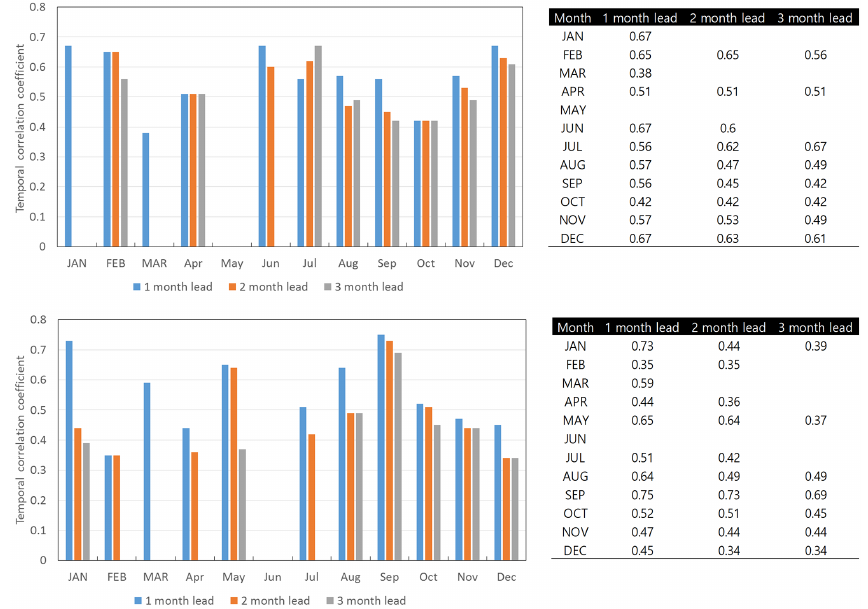
Figure 5. Temporal correlation coefficients (TCC) according to changes in lead time for predicting precipitation (top) and temperature (bottom) using multi-model ensemble (MME) average.